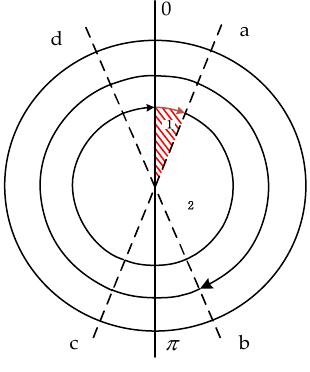
Figure 7. Single axis continuous rotation.